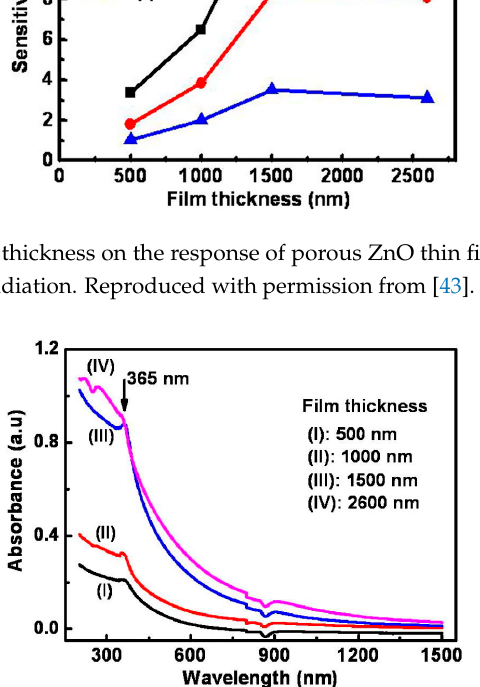
Figure 10. Optical absorbance spectra of porous ZnO porous film with different thicknesses. Reproduced with permission from [43].